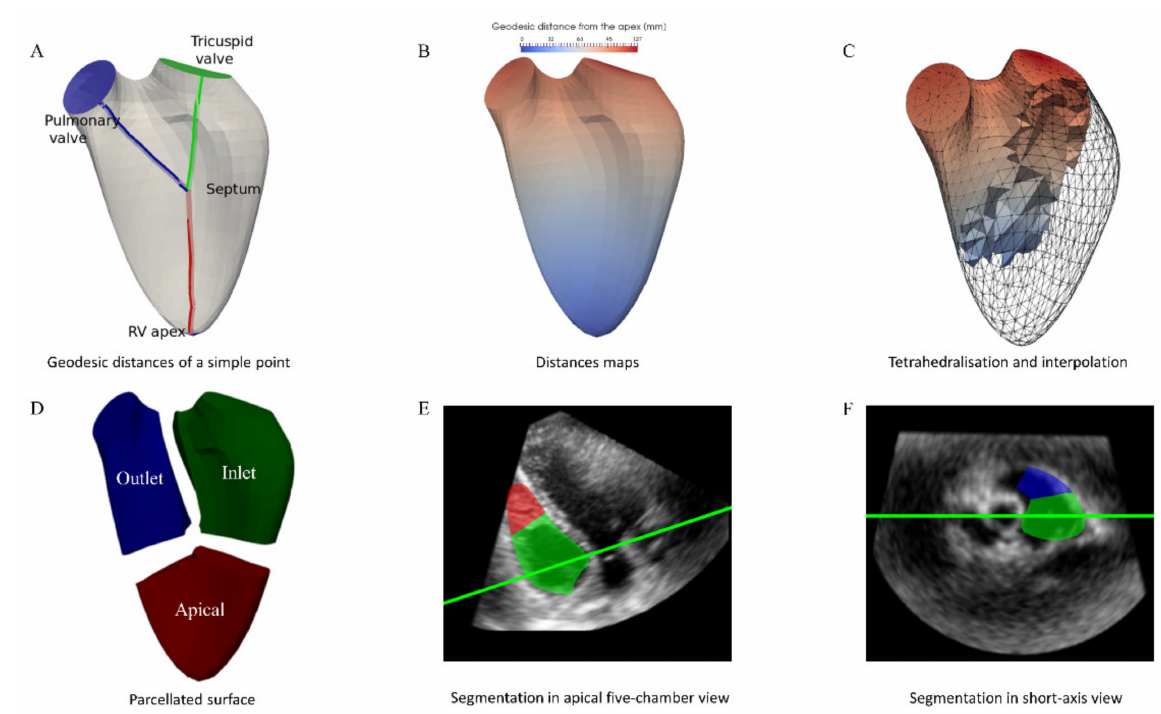
Figure 1. Illustration of different steps to generate the right ventricular volumetric partition. ( A ) For each point, the geodesic distances to the apex, tricuspid, and pulmonary valves are computed. ( B ) The geodesic distances to each of the landmarks define a scalar map over the surface mesh. ( C ) This distance map is extended from the surface to the cavity by tetrahedralising the mesh, and the Laplace equation is used to interpolate values to the interior. ( D ) The right ventricle is split into the regions by assigning each point of the cavity to the closest landmark. ( E , F ) Visualization of the RV parcellation over slices of the original 3D